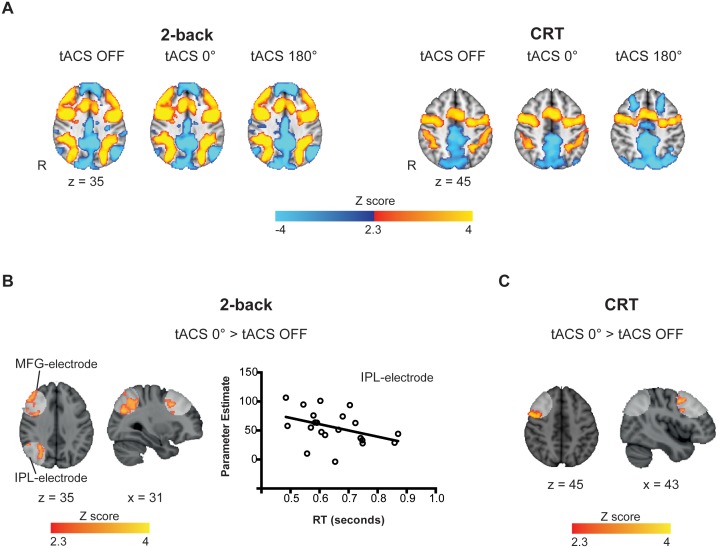
Task-related and tACS ROIs BOLD activity.(A) Activation patterns elicited by the 2-back (n = 21) and CRT (n = 20) tasks for tACS OFF, synchronous (tACS 0°) and desynchronous (tACS 180°) conditions. Warm colors represent increased BOLD signal relative to baseline (task > fixation tACS OFF) and cold colors a decrease in activity (fixation tACS OFF > task). (B) Increased activity in the IPL-electrode region is correlated with faster reaction times (RT) in the 2-back task condition (r = −0.39, p=0.039, one-tailed, n = 21). Y axis corresponds to the contrast estimates for the tACS 0° condition (extracted from the voxels showing increased brain activity for tACS 0° > tACS OFF, (A)) and the X axis corresponds to RTs during the synchronous tACS 0° condition. (C) During the CRT task, BOLD signal was increased in the MFG-electrode region for the synchronous tACS condition compared to task periods without tACS (n = 20). White regions indicate the tACS electrodes masks (tACS ROIs). Images are in the Montreal Neurological Institute (MNI) space coordinates and in radiological space. R=right hemisphere. Threshold Z > 2.3 with a corrected cluster significance level of p<0.05.DOI:
http://dx.doi.org/10.7554/eLife.22001.00710.7554/eLife.22001.008Figure 3—source data 1.This folder contains the MRI contrast maps in Figure 3A, both thresholded (that is, corrected for multiple comparison using cluster correction) and non-thresholded.The maps are in NIfTI format and can be opened with freely available data viewers such as FSLView or MRIcron.DOI:
http://dx.doi.org/10.7554/eLife.22001.00810.7554/eLife.22001.009Figure 3—source data 2.This folder contains the MRI contrast maps in Figure 3B, both thresholded (that is, corrected for multiple comparison using cluster correction) and non-thresholded and the IPL-electrode and MFG-electrode masks.The maps are in NIfTI format and can be opened with freely available data viewers such as FSLView or MRIcron.DOI:
http://dx.doi.org/10.7554/eLife.22001.00910.7554/eLife.22001.010Figure 3—source data 3.This table contains the mean reaction time and BOLD parameter estimates used for the correlation in Figure 3B.